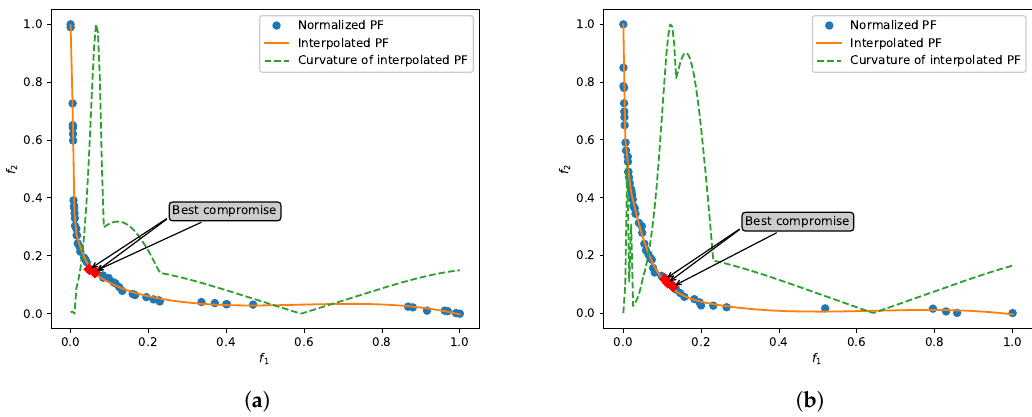
Figure 5. Normalized Pareto front and solution selection of ( a ) SalinasA and ( b ) KSC data sets. The curvatures are normalized for plotting it in a same coordinate. The best compromise is denoted as the top three points of closing to the maximum